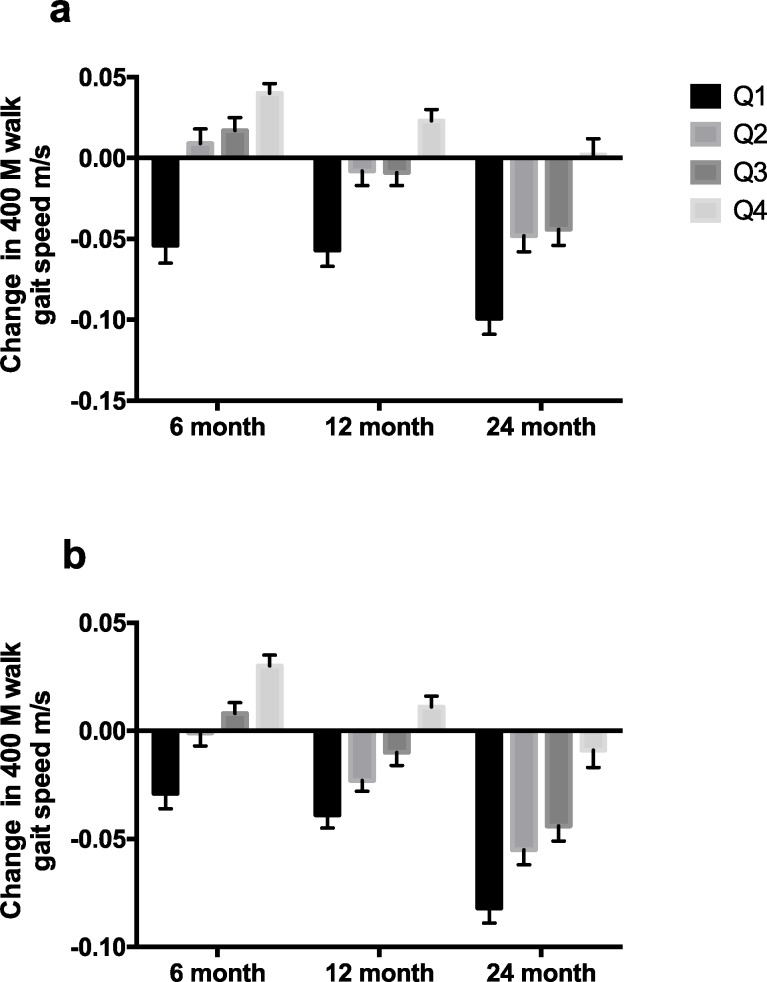
Change in 400 m walk gait speed (m/s) compared to baseline gait speed at 6, 12, and 24 months according to quartiles of change physical activity by accelerometry from baseline to 24 months, (a.) physical activity arm alone and (b.) entire group combined (least square means ± SE). Overall effect P < 0.0001. Effects within each time point P < 0.0001.